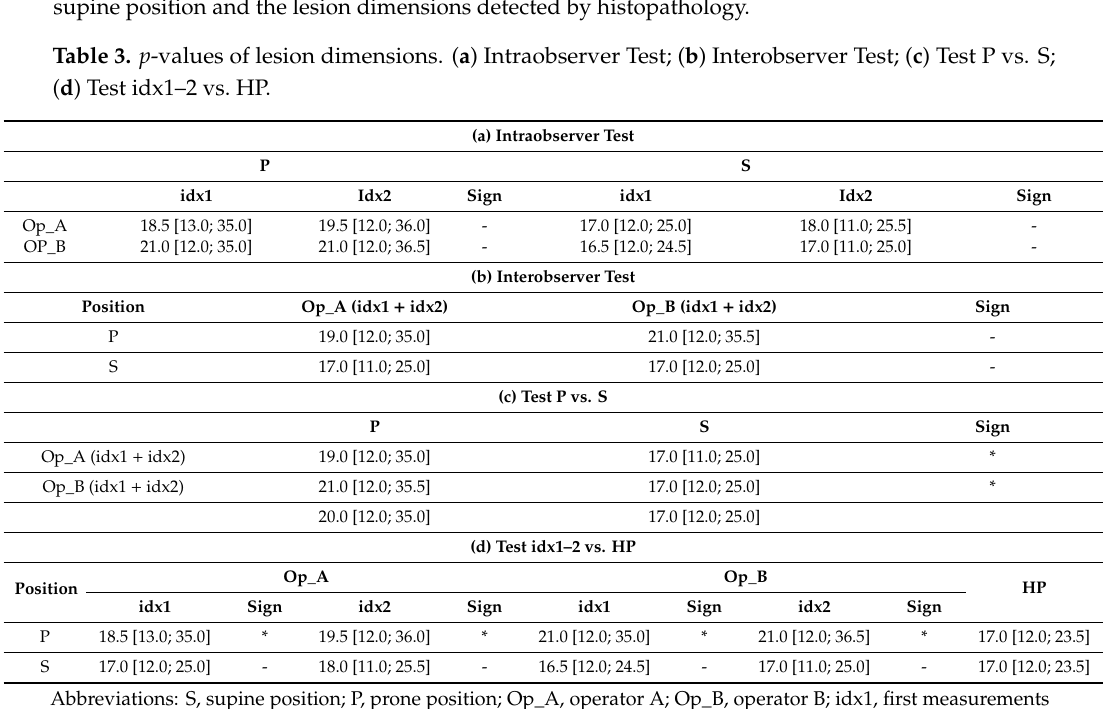
Table 4. Median and interquartile range of lesion dimensions considering mass-like and non-mass like